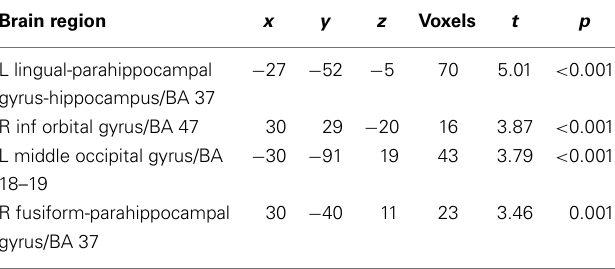
Table 1 | Regions parametrically modulated by Mviv > Pviv.